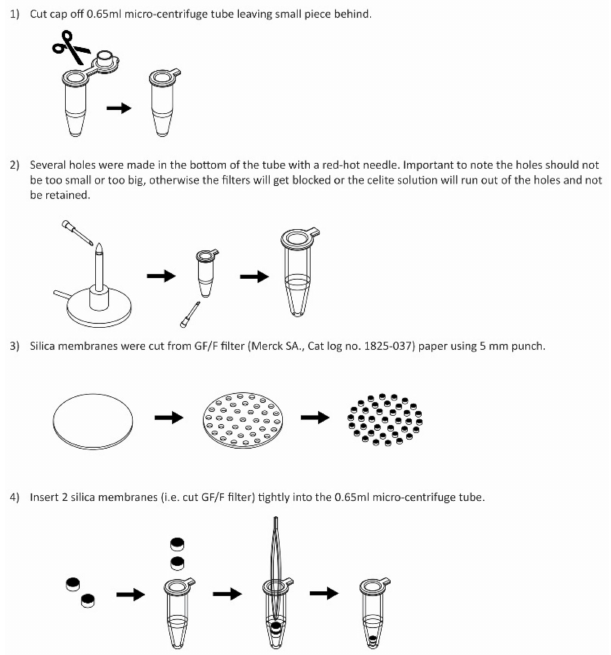
Figure 1. Process in making spin-columns in the